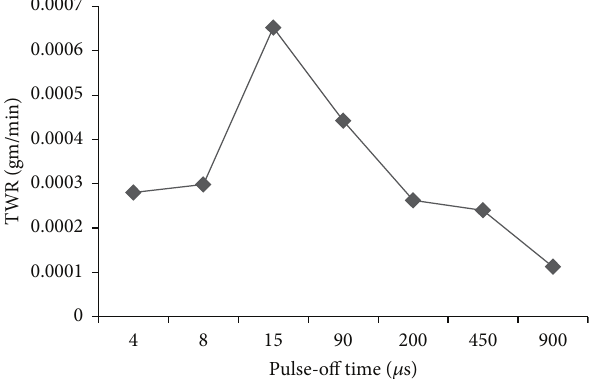
Figure 15: Influence of pulse-off time on TWR at constant current 9 Amp, gap voltage 60V, and pulse-on time 90 𝜇 s.